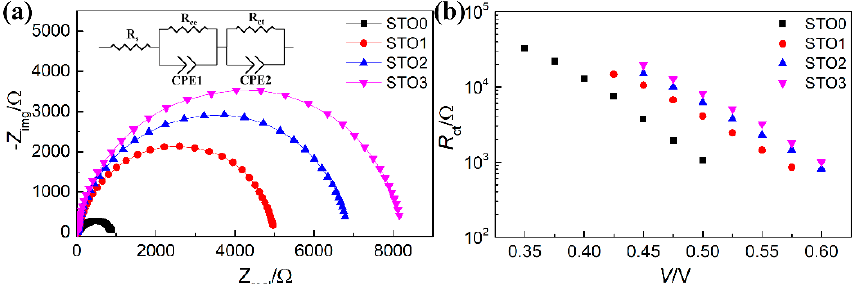
Figure 6. ( a ) Electrochemical impedance spectra of UVPDs based on STO0, STO1, STO2, and STO3 measured at 0.5 V bias voltage in dark condition ( b ) Plots of the inter- facial charge recombination resistance as a function of the applied bias voltage.